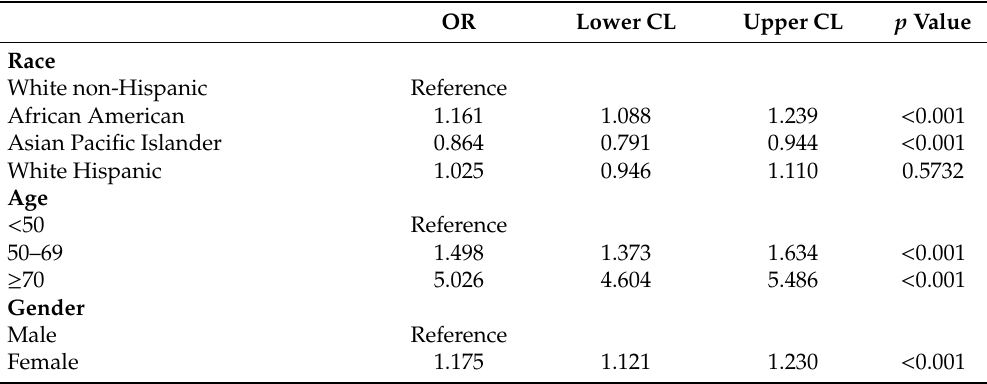
Table 5. Predictors of Non-Guideline Concordant Care for Stage II / III Gastric